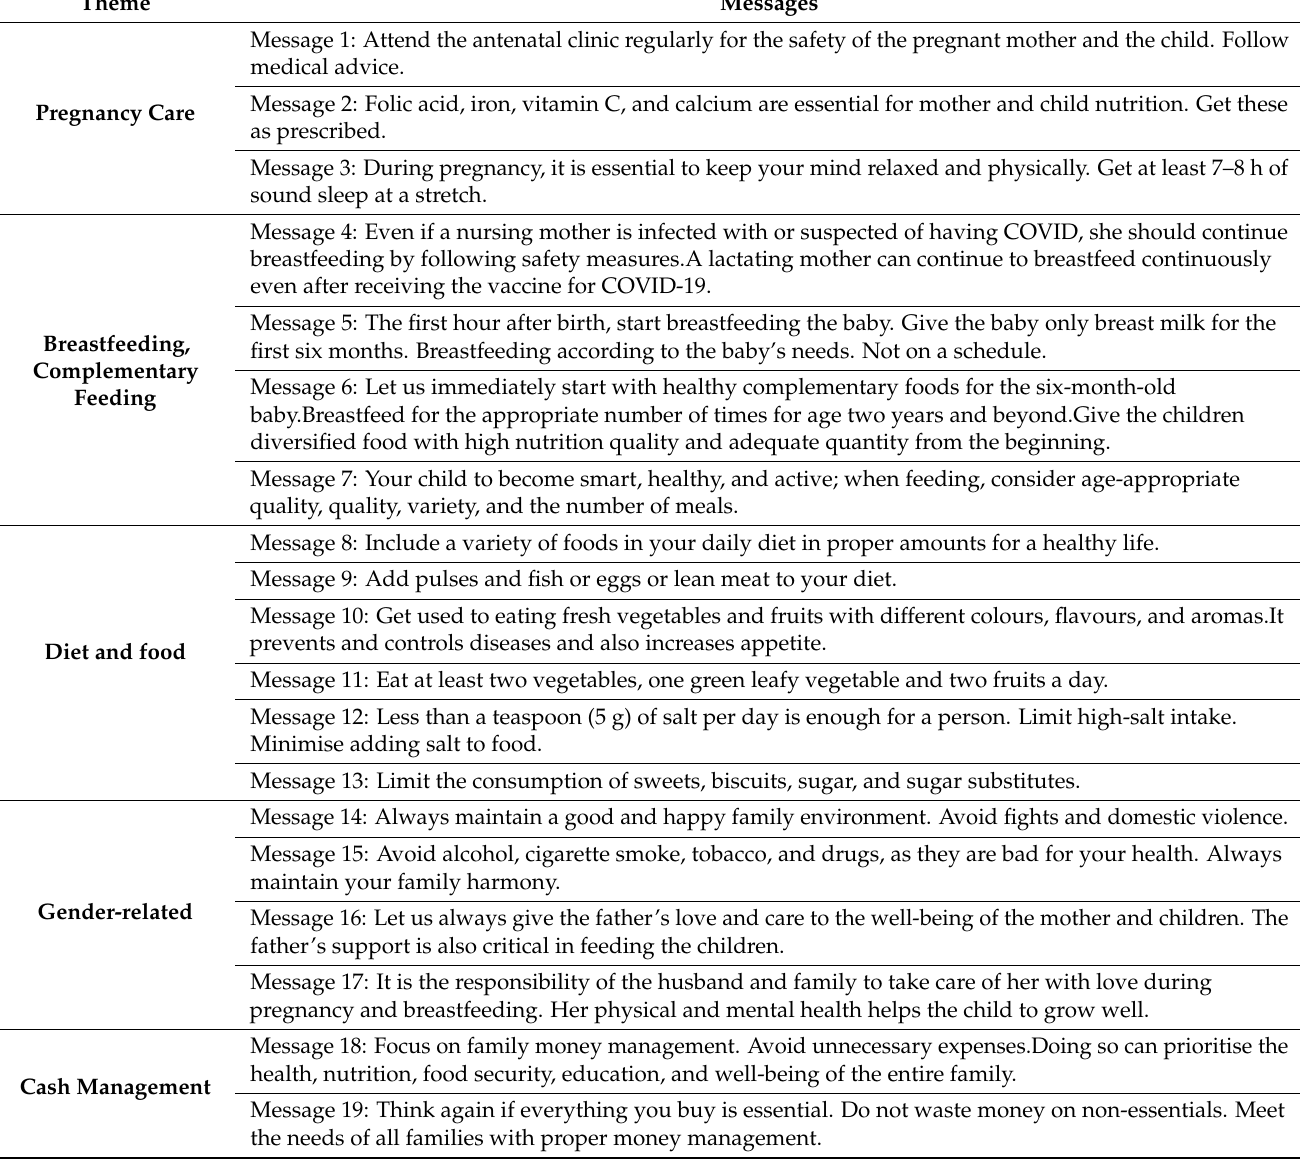
Table 2. Description of the intervention themes and messages.